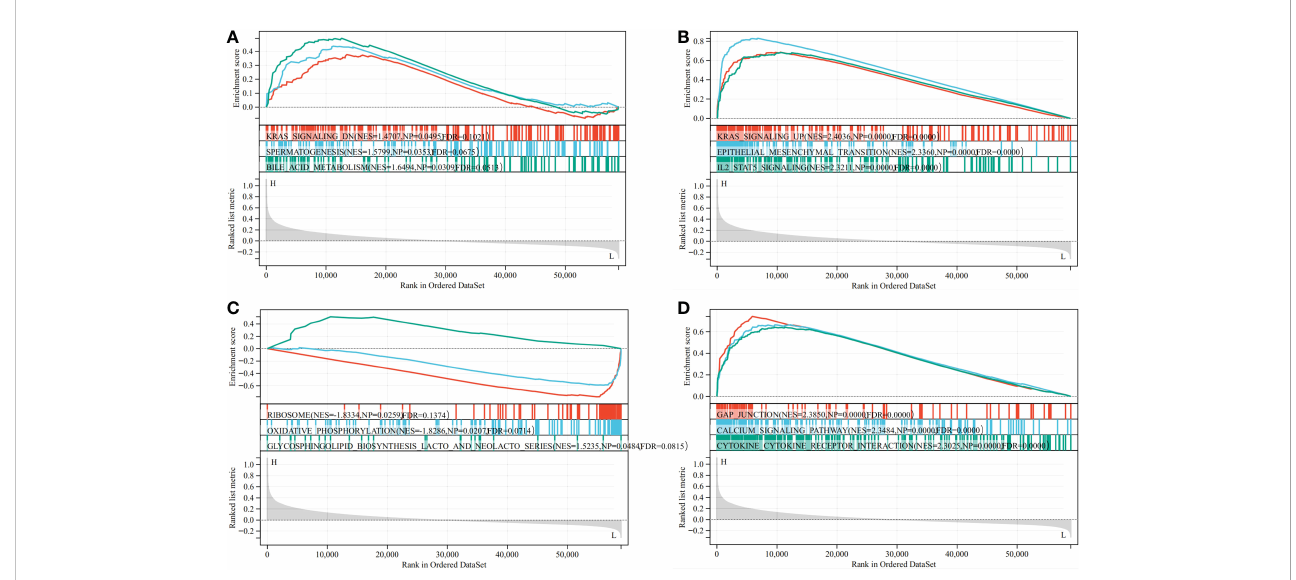
FIGURE 6 Result of Gene Set Enrichment Analysis (GSEA). GSEA (HALLMARK (A, B) and Kyoto Encyclopedia of Genes and Genomes (C, D) between CD93 high- and low-expression groups in stomach